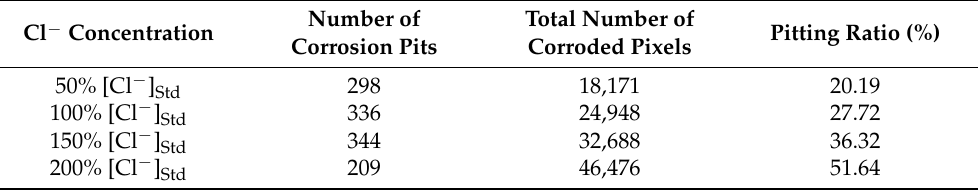
Table 5. Statistical values of corrosion characteristics at different Cl − concentrations .